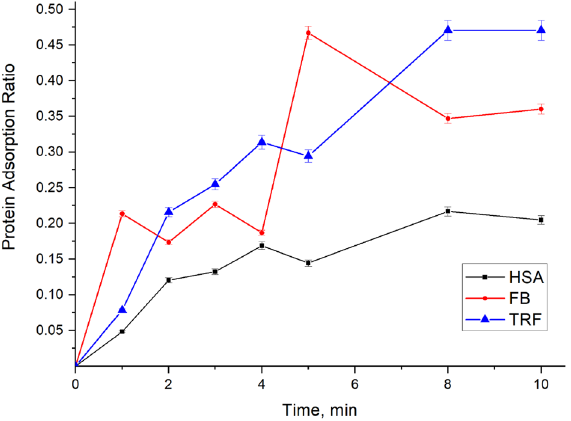
Figure 12. Proteins adsorption ratio* with time on PES clinical dialyzer (*adsorption ratio is the mass of adsorbed protein divided by the total mass of all protein adsorbed ×